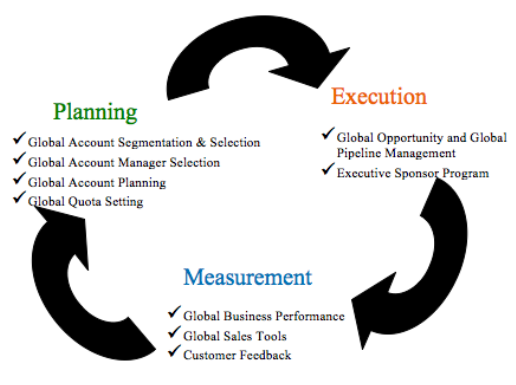
Figure 3 : An Iterative Model to Implement Key Initiatives to Drive